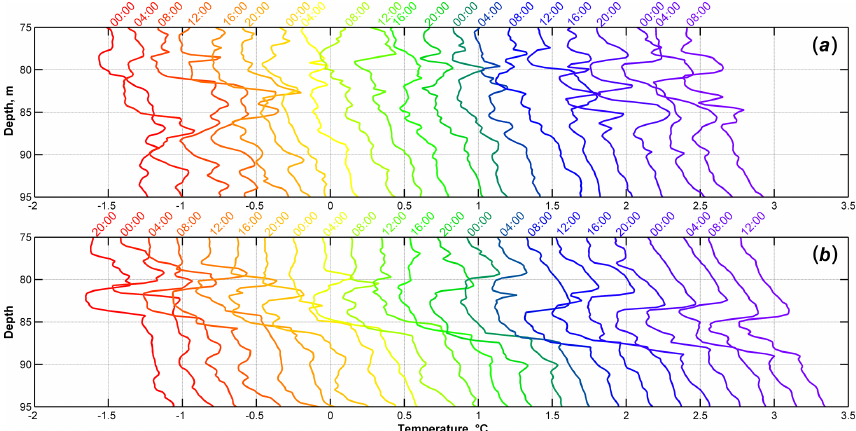
Figure 8. The evolution of intrusive layers within 75–95m depth during events (a) A (DOY 113–116.5) and (b) B (DOY 116.5–120). Each profile is offset 0.2 ◦ C from its neighbour, starting from the first profile.